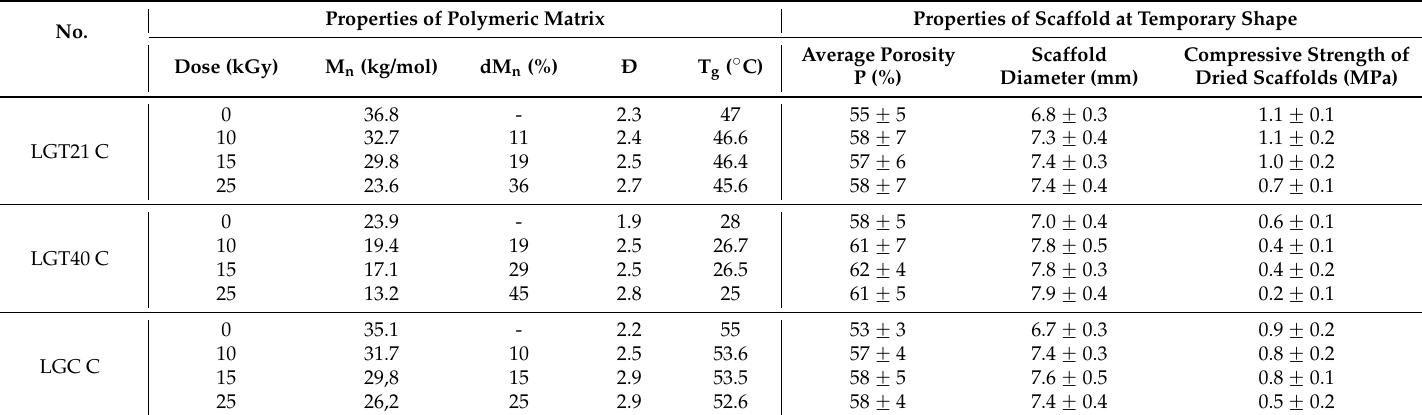
Table 2. Effect of γ irradiation dose on properties of terpolymers and scaffolds at their temporary